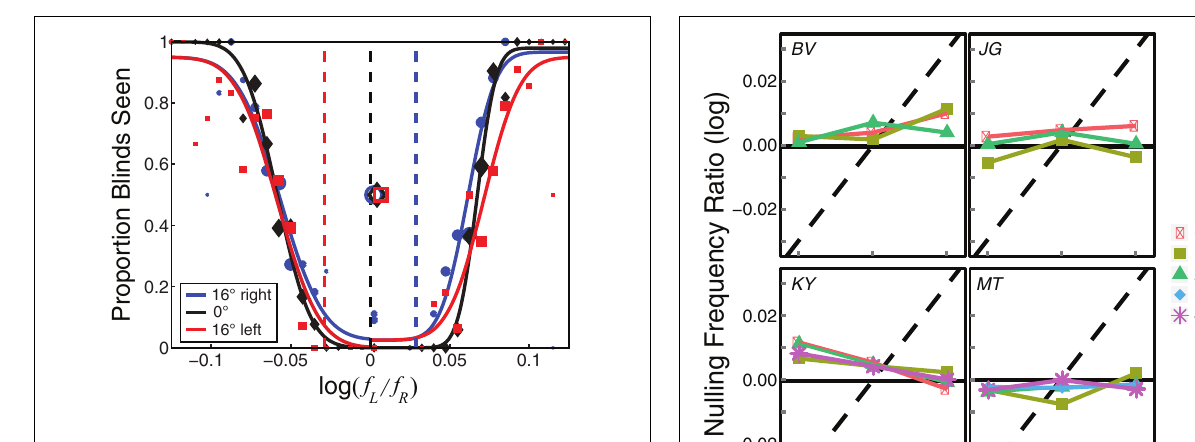
FIGURE 4 | The probability of seeing Venetian blinds as a function of inter-ocular frequency ratio. The proportion of trials on which blinds were reported is plotted as a function of the logarithm of the inter-ocular frequency ratio. The red circles, black squares, and blue diamonds represent the data for leftward, forward, and rightward gaze, respectively. The size of the data symbols is proportional to the number of trials presented at that particular frequency ratio. The curves are cumulative Gaussians fit to the data. The open data symbols are the average of the two ratios that produced blinds on half the trials (i.e., the average of the 50% points on the two cumulative Gaussians fit to each data set.) The black dashed vertical line is the prediction for zero disparity for leftward, forward, and rightward gaze. The red, black, and blue dashed lines are the predictions for zero slant for leftward, forward, and rightward gaze, respectively.